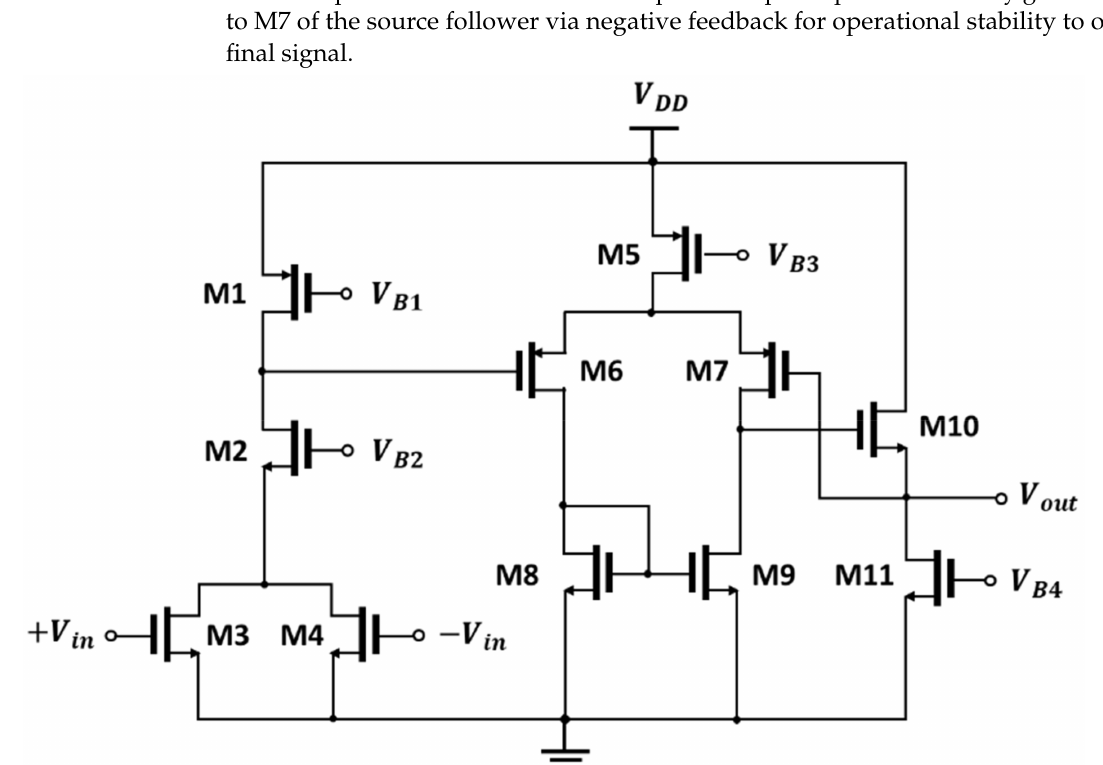
Figure 6. Schematic of the preamplifier with a voltage